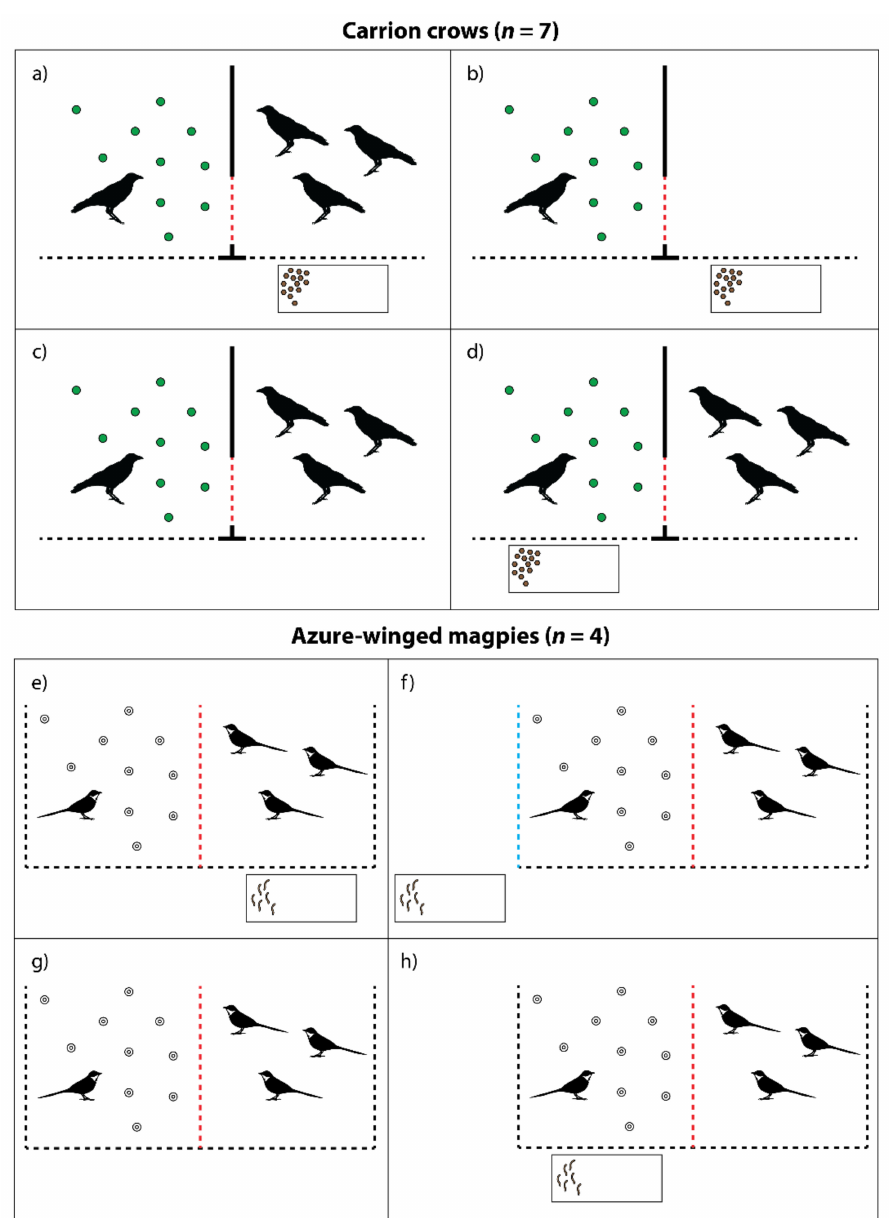
Figure 1. Schematic representation of the experimental setup in the four different conditions for the carrion crows ( a ) test; ( b ) non-social control; ( c ) social control; and ( d ) motivation control and for the azure-winged magpies ( e ) test; ( f ) non-social control; ( g ) social control; and ( h ) motivation control. The red dashed line indicates the wire mesh partitioning separating the two experimental compartments. The blue dashed line indicates the wire mesh of the aviary opposite the other compartment, near to where the exchange table was placed in the non-social control condition for the azure-winged magpies. The dimensions in the drawing are not to